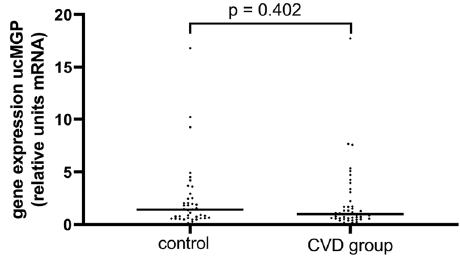
Figure 1: ucMGP expression levels in PBMC according to CVD